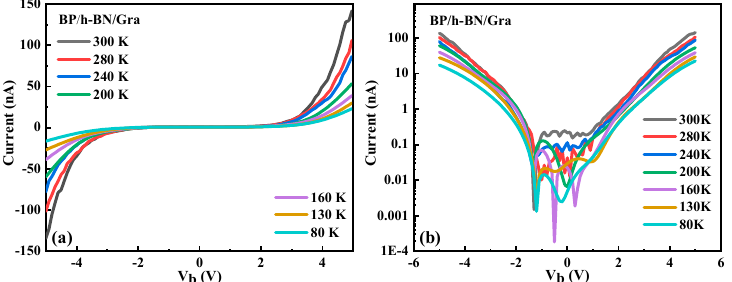
Figure 4. ( a ) Current as a function of V b at different temperatures. ( b ) Logarithmic current-bias plot.